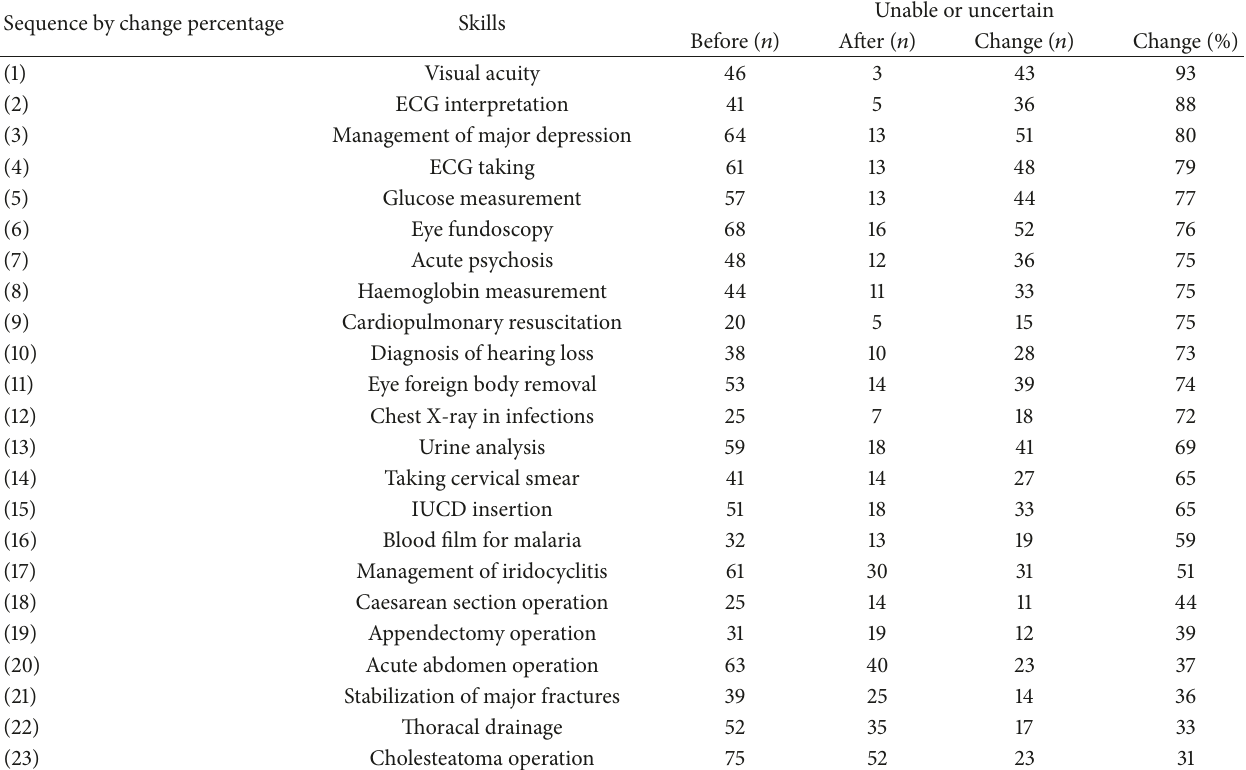
Table 2: Changes in the numbers and percentages of the master’s programme candidates who were “unable” or “uncertain” when performing certain skills before and after the GFMP, Gezira state, Sudan ( 𝑁 = 108